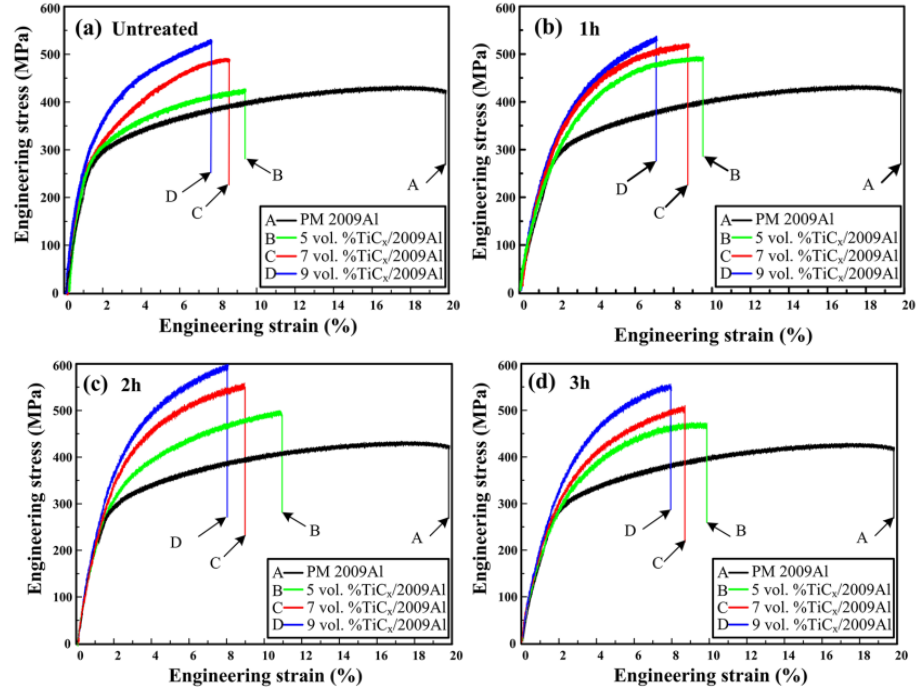
Figure 4. Engineering stress-strain curves of PM 2009Al and 5, 7, 9 vol% nano-sized TiC x /2009Al composites prepared by using ( a ) untreated CNTs and CNTs milled for ( b ) 1 h; ( c ) 2 h and ( d ) 3 h as the carbon source. Table 1. The tensile test data of 2009Al.